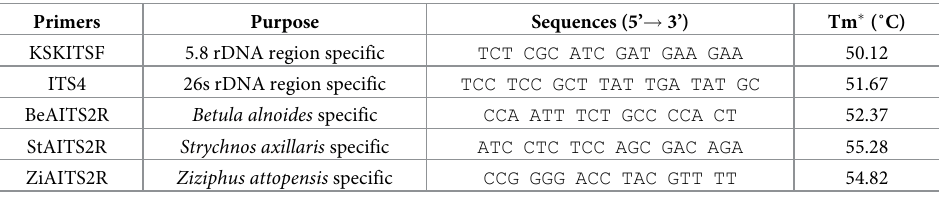
Table 2. Primers used for multiplex